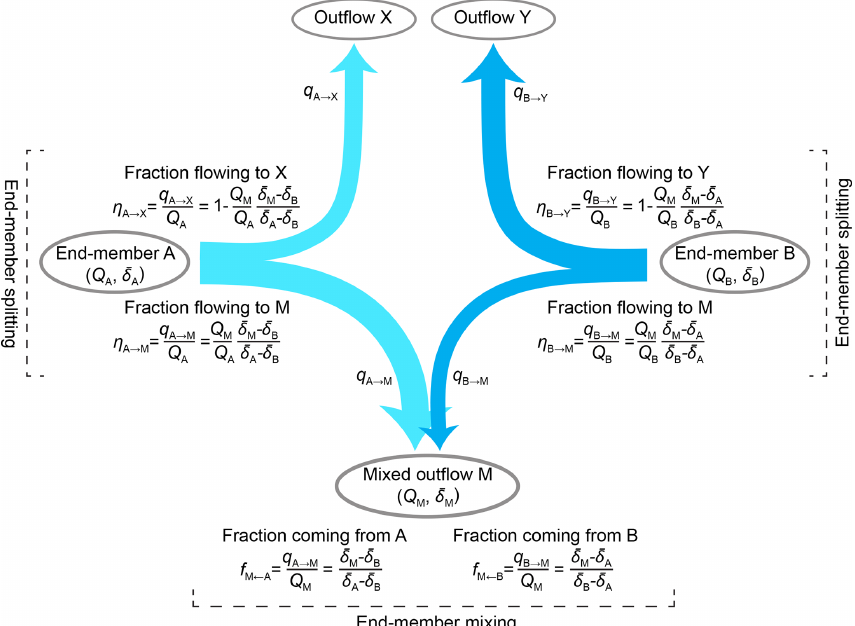
Figure 1. Schematic illustration of end-member mixing and end-member splitting. Two end-members, A and B, contribute to a mixed outflow M and to two other outflows, denoted X and Y, respectively. The fluxes between the end-members and outflows are denoted q A → M , q A → X , q B → M , and q B → Y ; these are assumed to not be directly measurable. Conventional end-member mixing, as shown at the bottom of the figure, can be used to calculate the fractions of the two end-members in the mixture using only their volume-weighted average tracer signatures ( δ A , δ B , and δ M ). If one also knows the water fluxes in the mixed outflow and one or both end-members, one can use end-member splitting, as shown on the left- and right-hand sides of the figure, to quantify how the end-members are partitioned between the mixture M and their other outflows X and